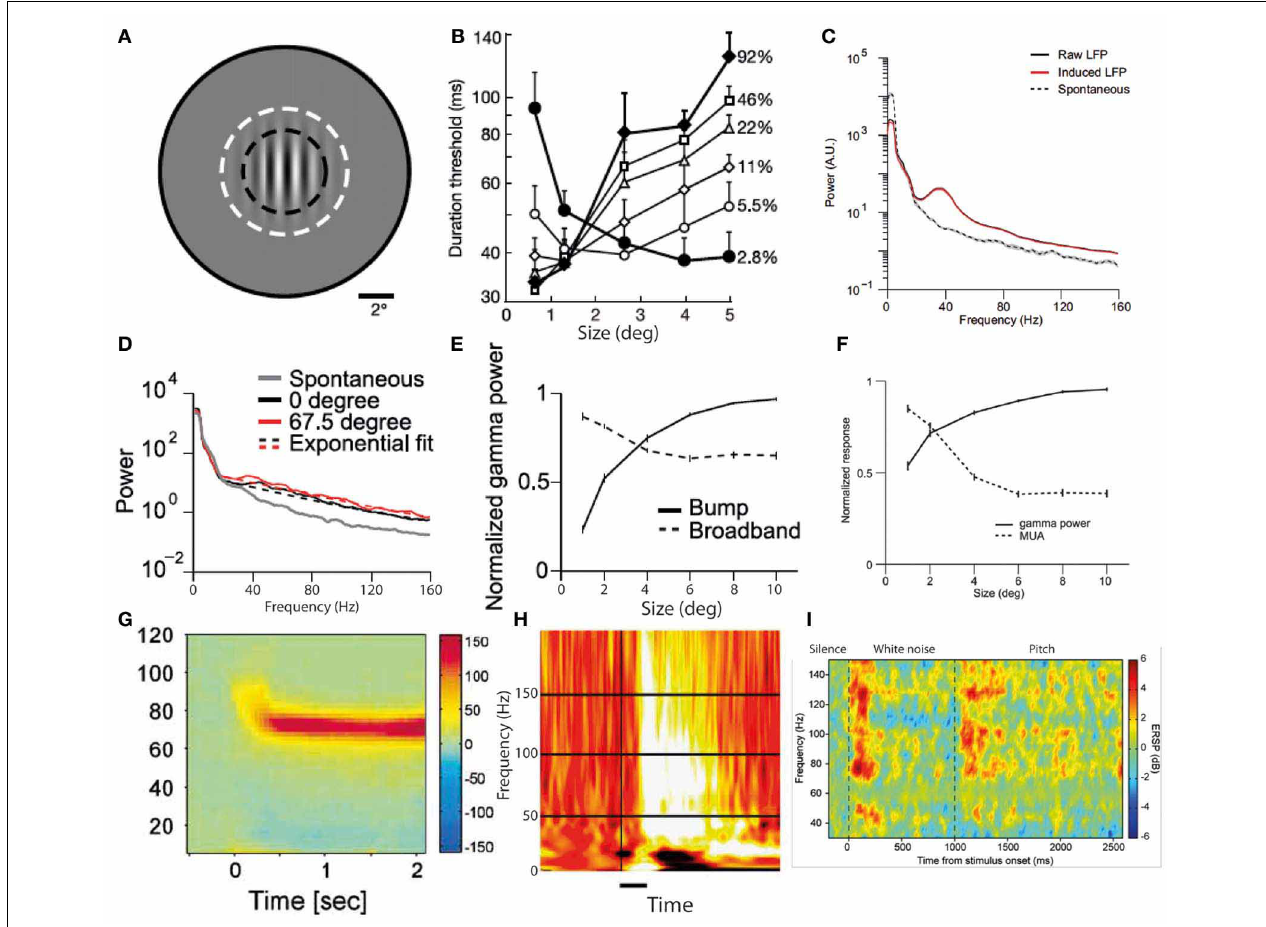
FIGURE 2 | Two predominant types of gamma oscillations: narrowband and broadband. (A) Visual grating stimulus of type that produces both perceptual surround suppression and visual cortex narrowband gamma oscillations. (B) Duration thresholds, for detecting the direction in which the grating drifts, as a function of stimulus size (degrees) and stimulus contrast (%). Note that above 2 ◦ in size, thresholds become longer for high contrast stimuli, indicating surround suppression (A,B reproduced with copyright-holder’s permission from Tadin et al., 2003). (C) Oscillatory power changes in macaque visual cortex in response to large visual grating stimuli ( > 2 ◦ ), showing a prominent narrowband peak around 40Hz, as well as a smaller broadband gamma increase. (D) Equivalent to (C) , but for smaller stimulus ( < 2 ◦ ). Note that only a broadband gamma increase occurs. (E) Antagonistic relationship between narrowband (“bump”) and broadband gamma power in response to visual grating stimuli of increasing size. (F)